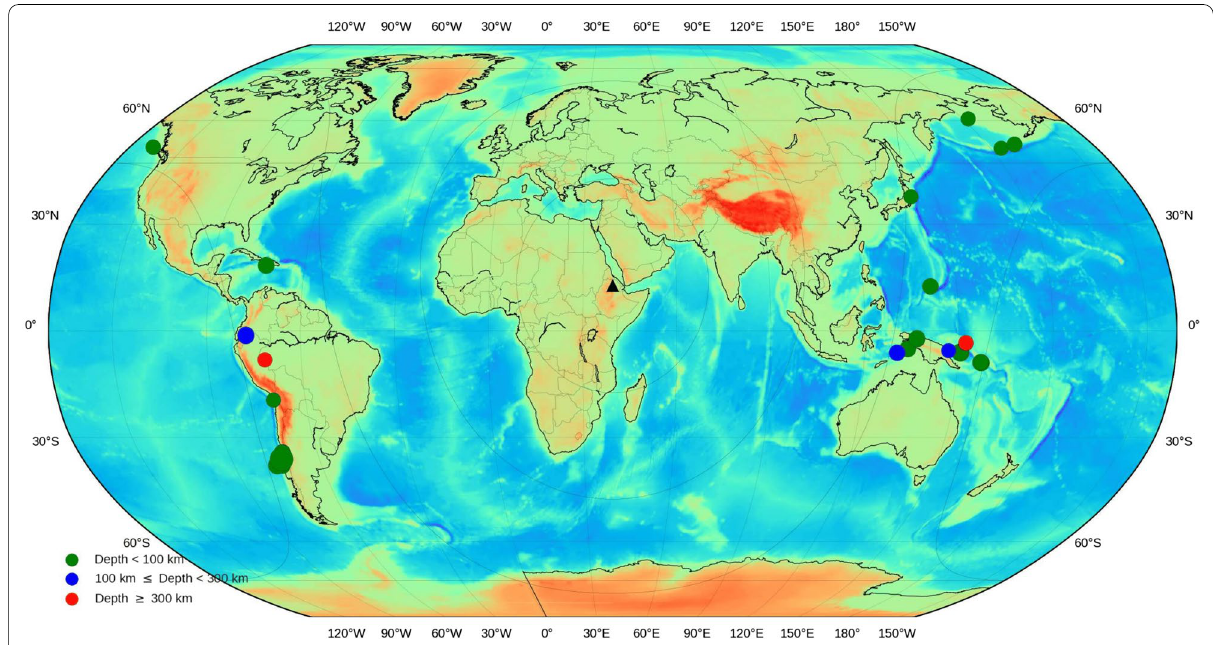
Fig. 6 Selected events for the computation of shear-wave splitting parameters for a single seismic station